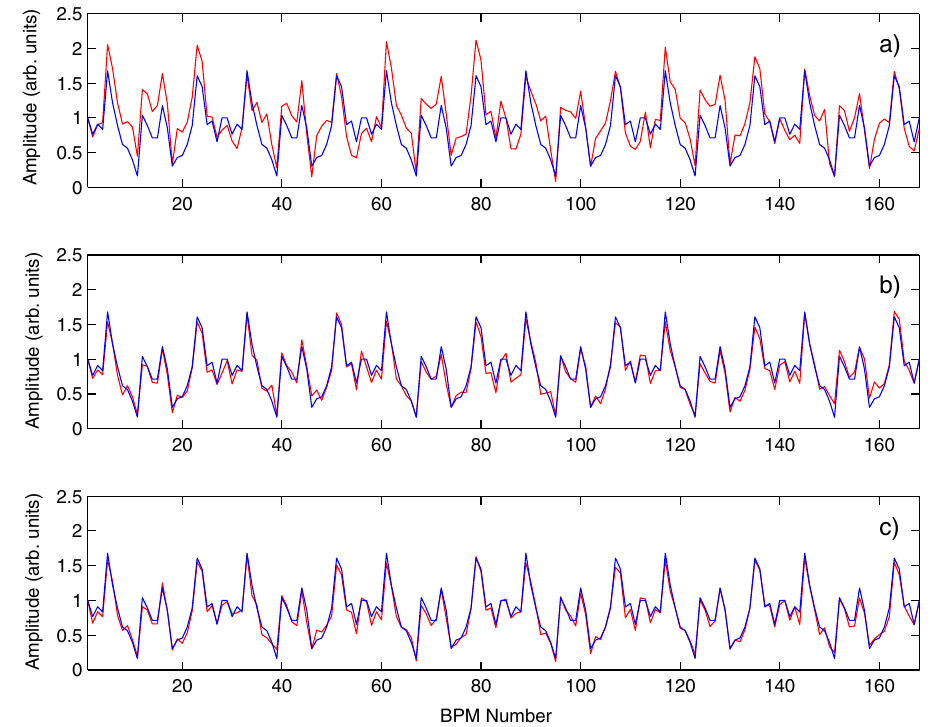
FIG. 6. (Color) Correction of a single resonance by fitting the ð(cid:1) 1 ; 1 Þ line in the vertical plane: before correction (a); after one iteration (b); after two iterations (c). The spectral line from the model is blue while the measured one is in